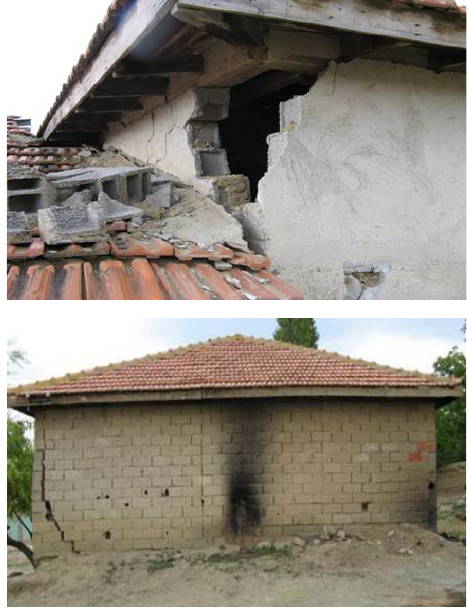
Fig. 18. Examples of masonry buildings formed by concrete Fig. 18 Examples of masonry buildings formed by concrete briquette with vertical holes or briquette with vertical holes or lightweight concrete lightweight concrete briquette